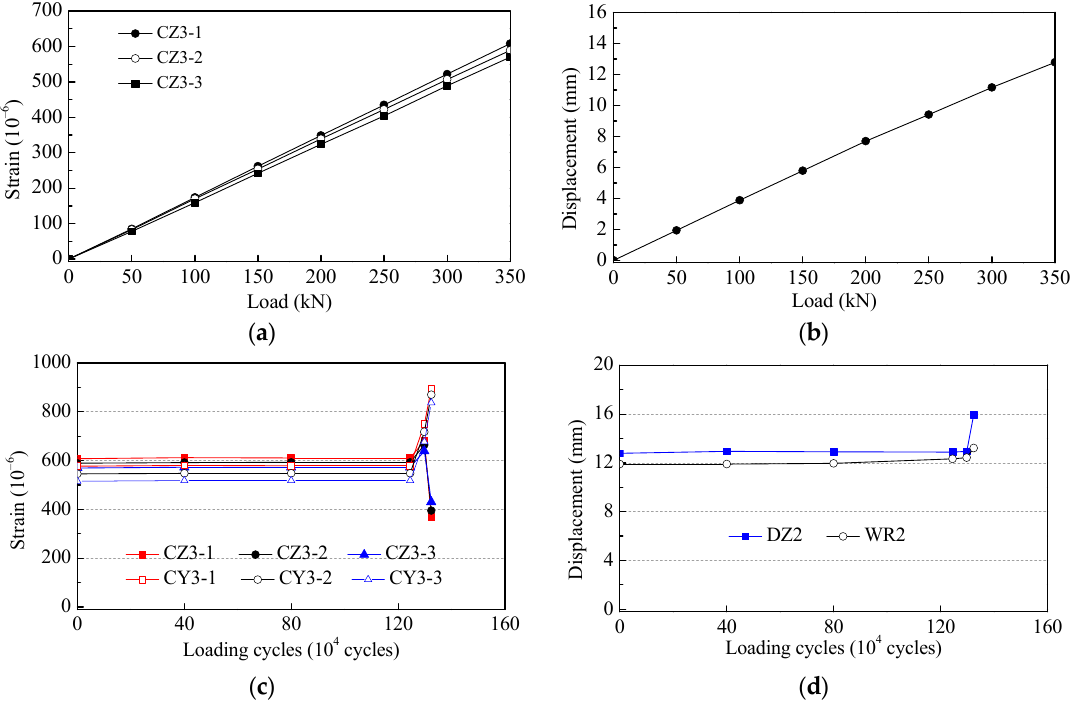
Figure 7. Analysis off results under static load: ( a ) load-strain curves, ( b ) load-displacement curves, ( c ) loading cycles—strain curves, and ( d ) loading cycles—displacement curves.